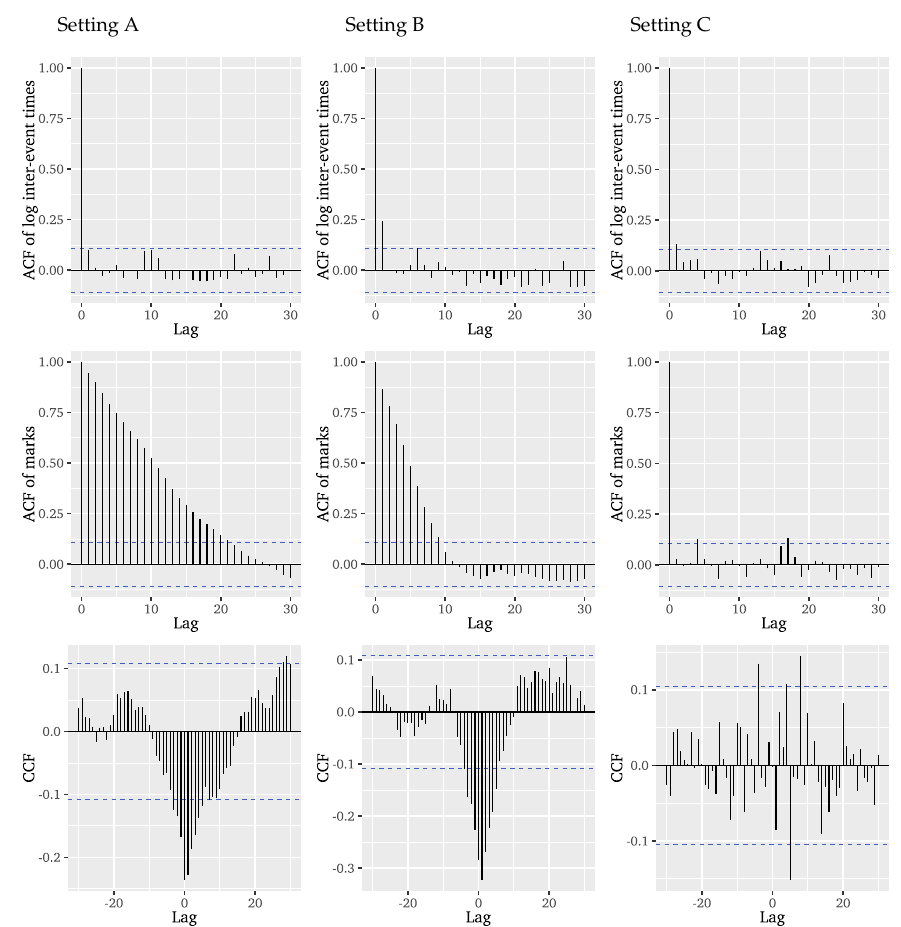
Figure 15. Autocorrelation functions of logarithmic inter–event times, event marks, and their cross– correlation function for simulated settings A, B, and C.